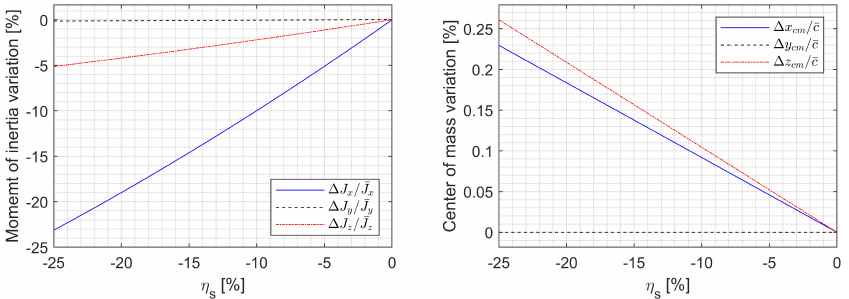
Figure 3. Parameter variation due to η s when η a =